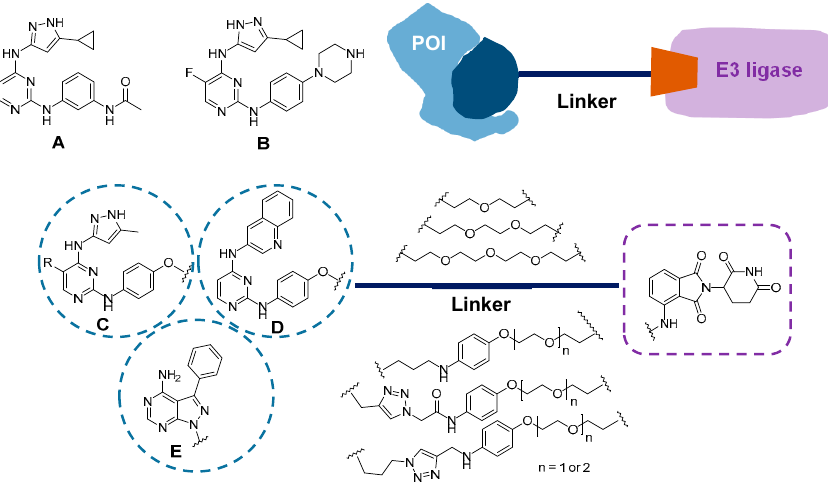
Figure 1. Chemical structures of representative Src inhibitor A , IGF-1R inhibitors B , and a schematic diagram of PROTACs for IGF-1R and Src.